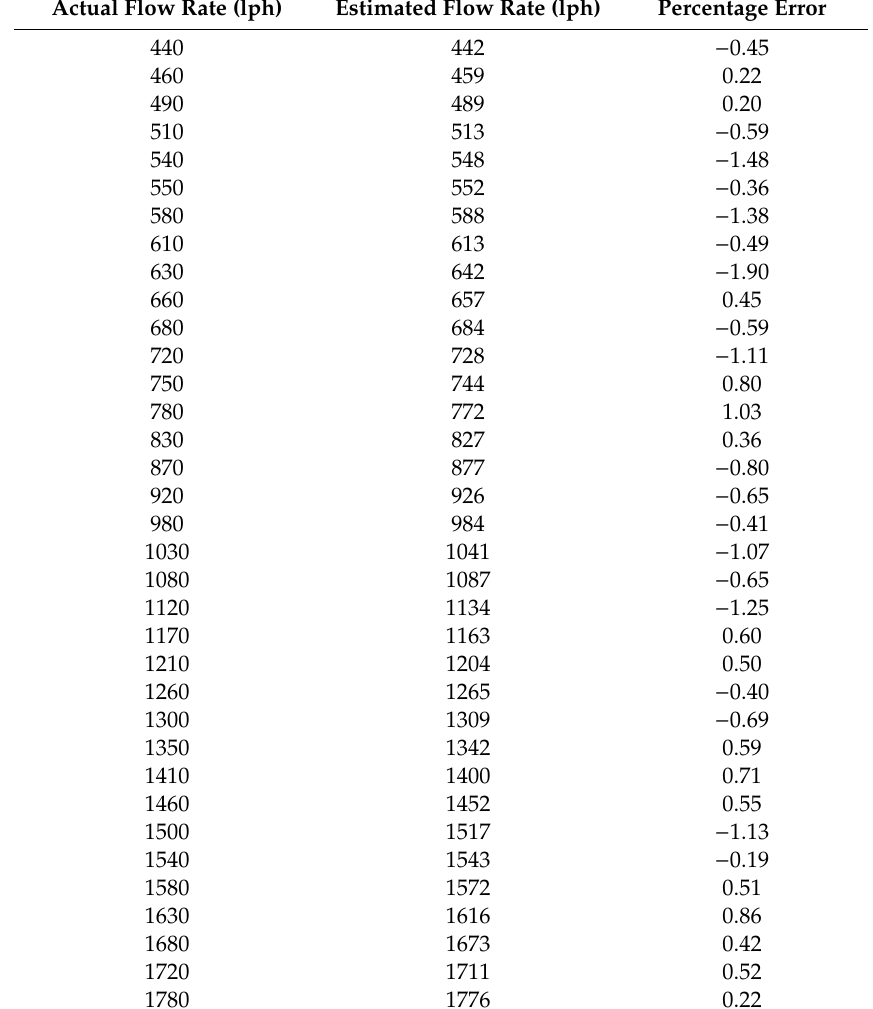
Table 3. Results obtained for input-output testing.